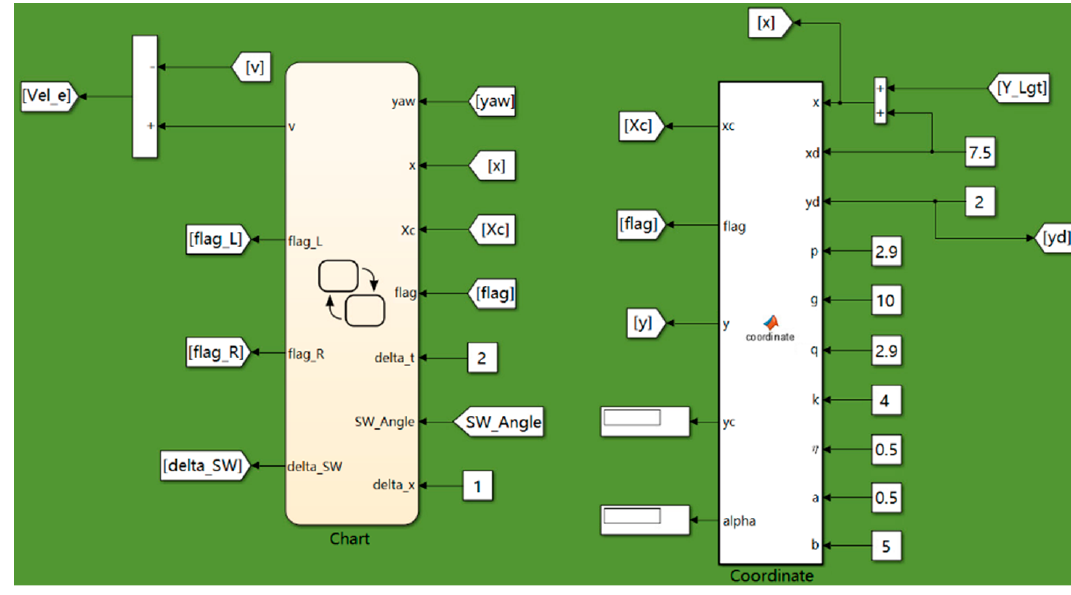
Figure 16. Speed Control Module.